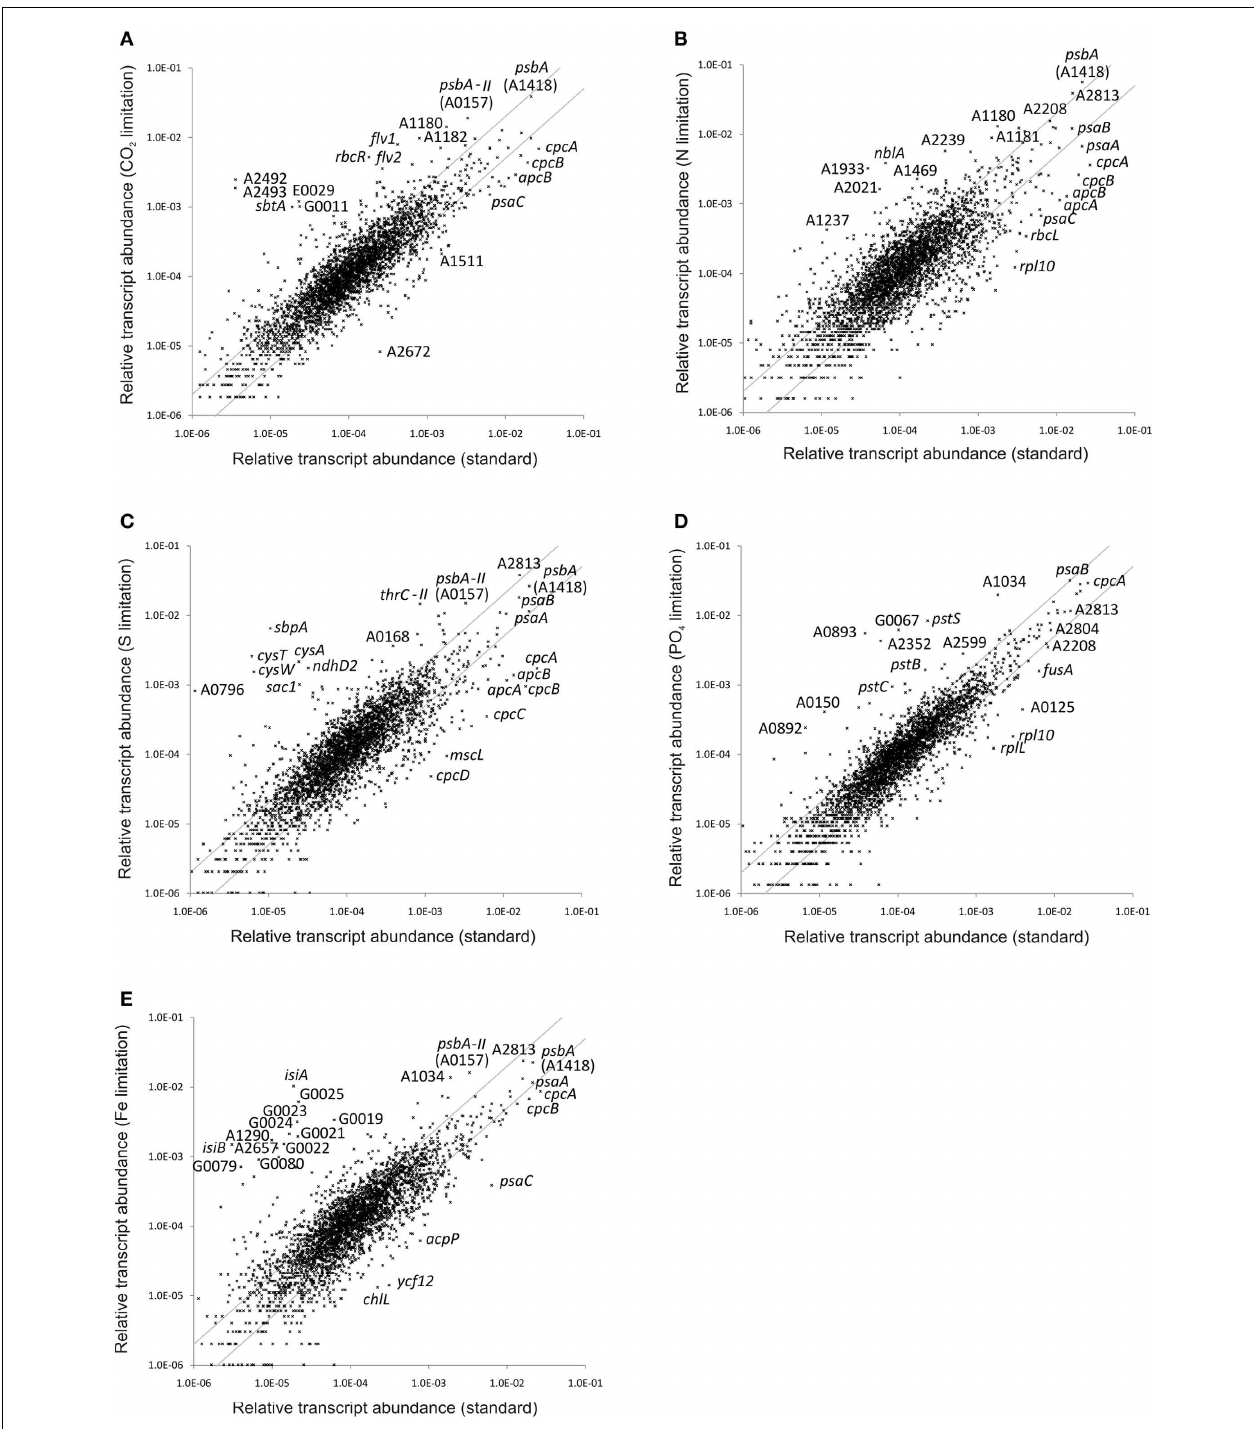
FIGURE 1 | Changes in the relative transcript abundance upon nutrient limitation. The scatter plots show the relative transcript abundances (A) when grown with low CO 2 supply and after (B) nitrogen, (C) sulfur, (D) phosphate,